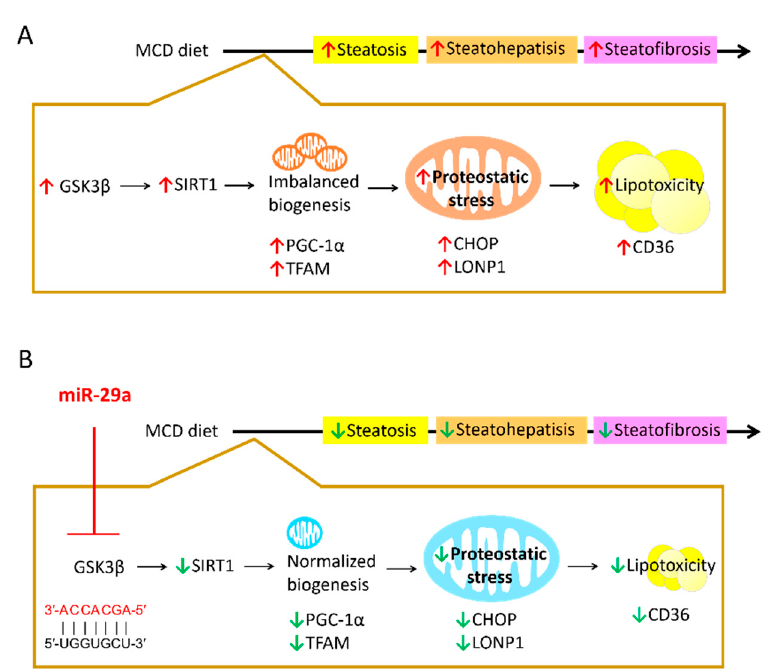
Figure 7. Proposed model of the miR-29a-relayed pathway in the prevention of diet-induced hepatic injury . ( A ) MCD diet leads to an increase in GSK3 β , which induces imbalanced mitochondrial biogenesis mediated by SIRT1. As such, protein folding workload in mitochondria can stimulate proteostatic stress, leading to mitochondrial malfunction and subsequent hepatic lipid accumulation. Increased hepatic lipotoxicity can contribute to the progression of steatosis, steatohepatitis and steatofibrosis. ( B ) miR-29a can suppress GSK3 β expression by direct binding to its 3 ′ UTR to reverse the aberrant SIRT1-mediated mitochondrial biogenesis and mitochondrial proteostatic stress, ultimately mitigating the pathological progression. Red arrow: increase; Green arrow: decrease.